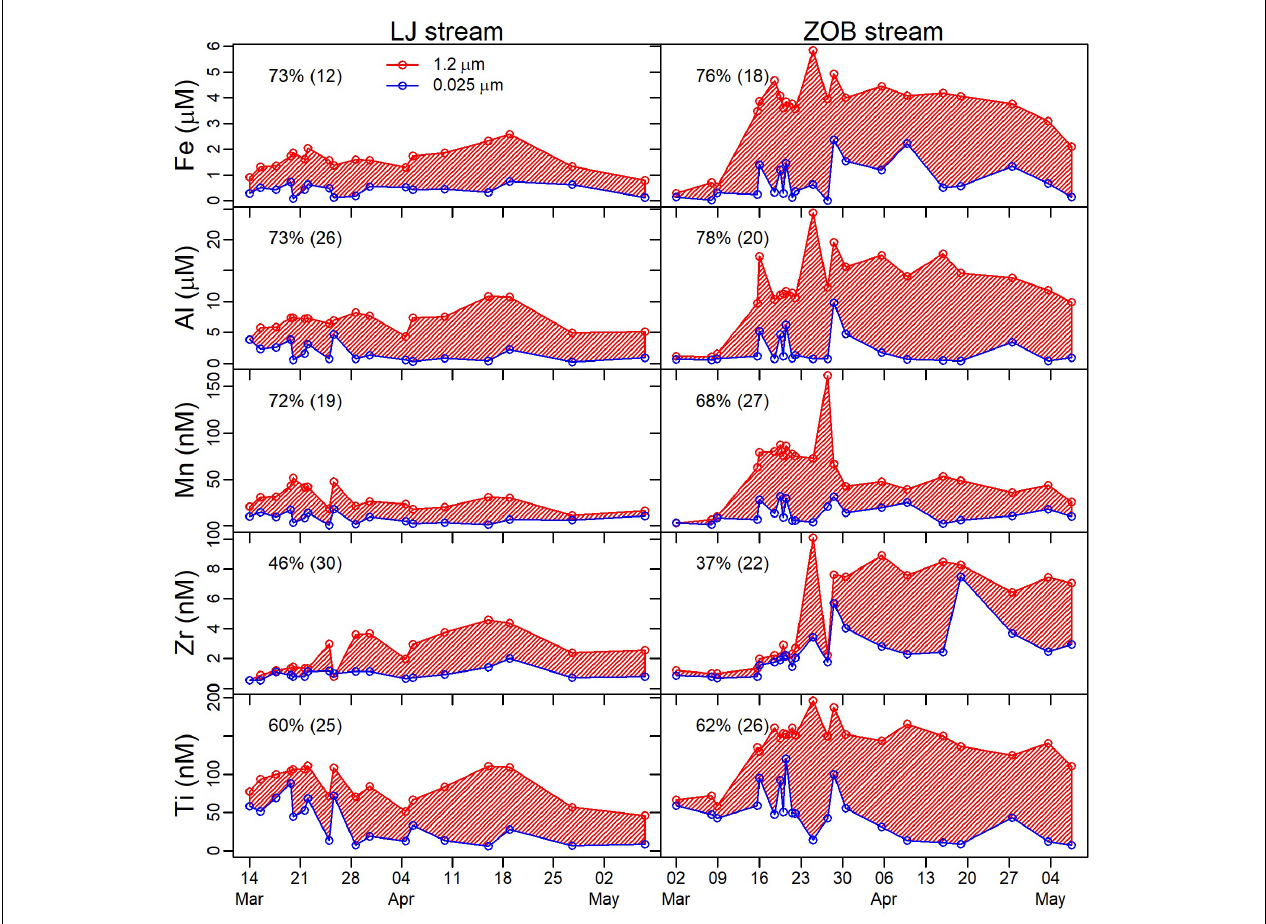
FIGURE 5 | Time series results for the cascade filtration data pertaining to Fe, Al, Mn, Zr, and Ti. Concentrations are shown for elements in filtrates following filtration at 1.2 µ m (red) and 0.025 µ m (blue). Area marked in red diagonal lines represents the elemental mass contribution of colloids (0.025–1.2 µ m). Numbers inset in each plot are the mean and standard deviation of the colloidal fraction over the course of the